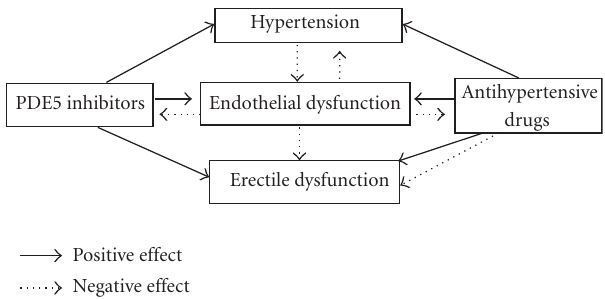
Figure 1: Relationship between hypertension and erectile dysfunction. PDE5, phosphodiesterase